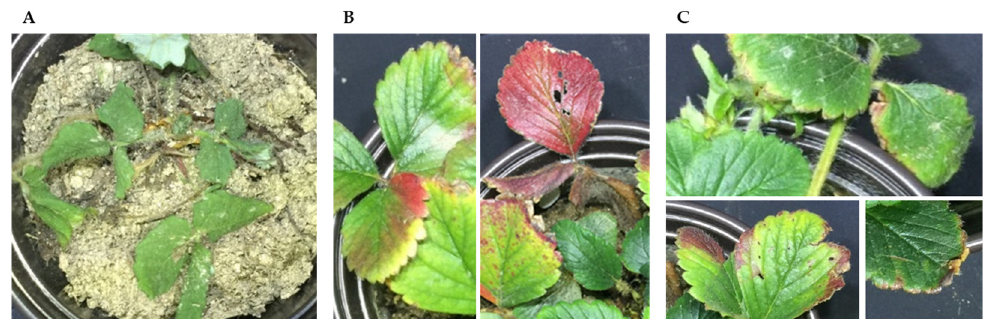
Figure 2. Symptoms of physiological disorders in experimental plants: ( A ) wilt, ( B ) yellowing of leaves, and ( C ) browning of leaves.